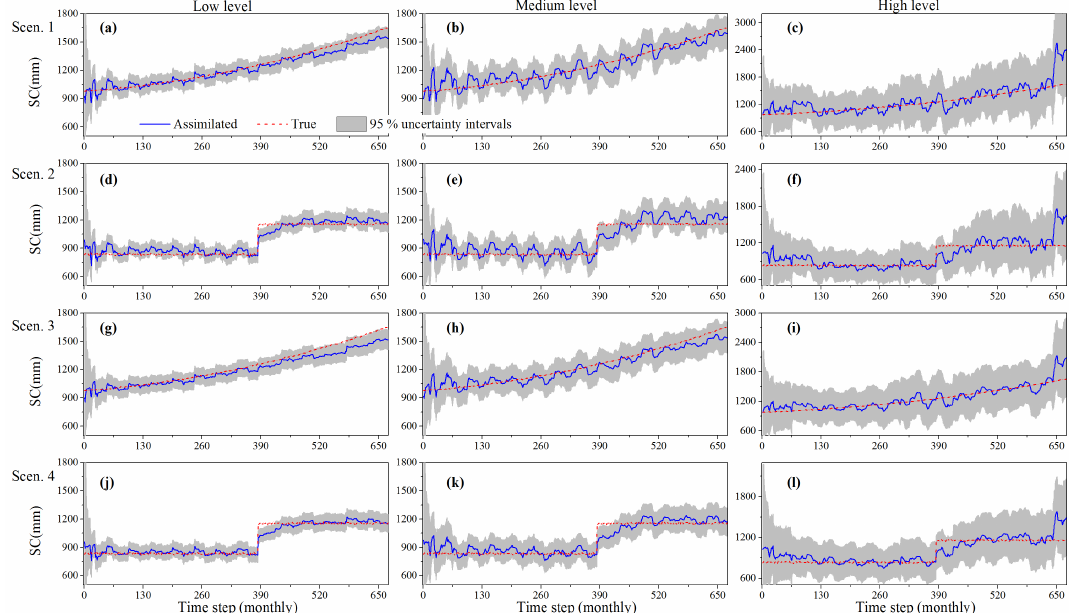
Figure 4. Comparison between estimated SC and its true values for various parameter changes under different uncertainty levels. The gray areas represent the 95% prediction uncertainty